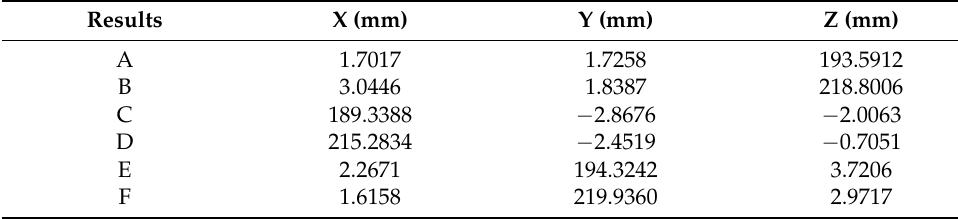
Table 10. Result of space points coordinates.